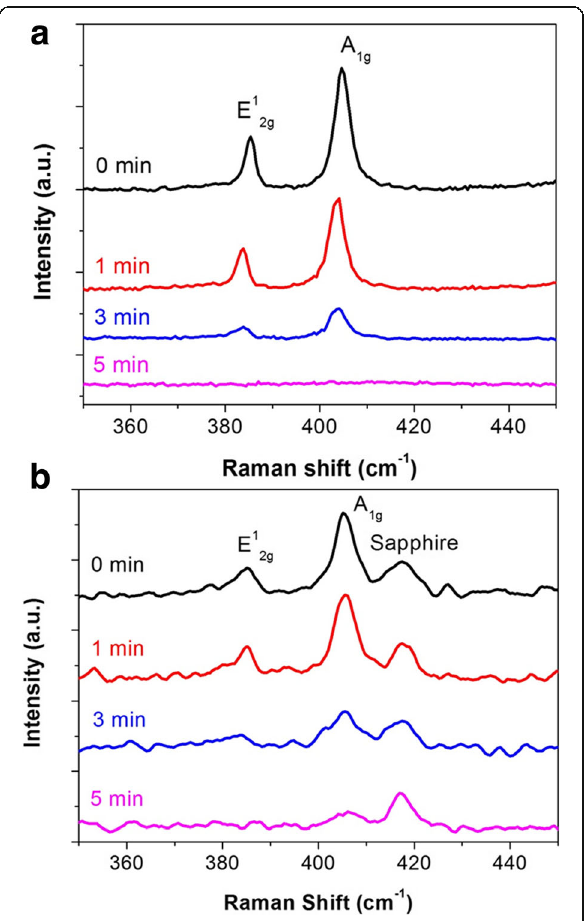
Fig. 4 Raman spectra of MoS 2 monolayers a mechanically exfoliated flakes on SiO 2 /Si substrates and b CVD thin films on sapphire substrates after UV-O 3 treatment for 0, 1, 3, and 5